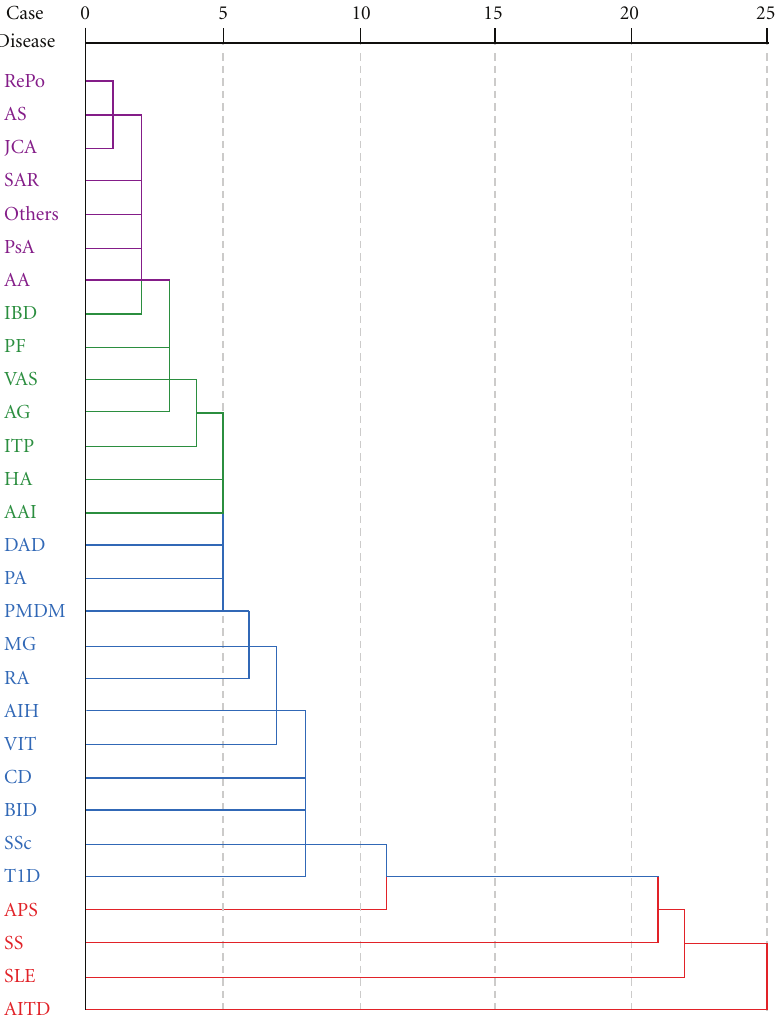
Familial autoimmunity and female gender were con- firmed as risk factors for polyautoimmunity. Female